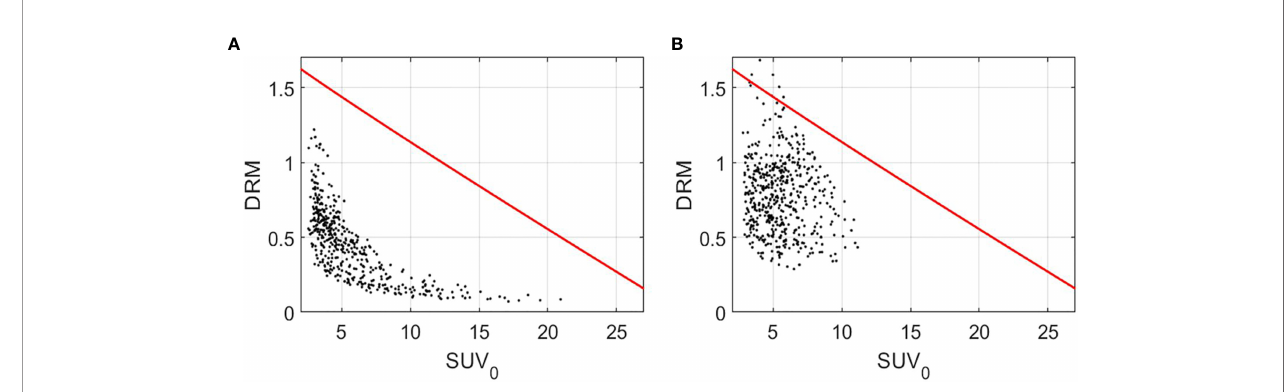
FIGURE 1 | Tumor voxel (SUV 0 , DRM) for a local control tumor (A) and a local failure tumor (B) with the boundary function, BF = − 0 : 07 · SUV 0 : 95 0 ( v ) + 1 : 76 (red curve). DRM and BF were constructed using the PET feedback image acquired during the 3rd treatment week. DRM, dose –